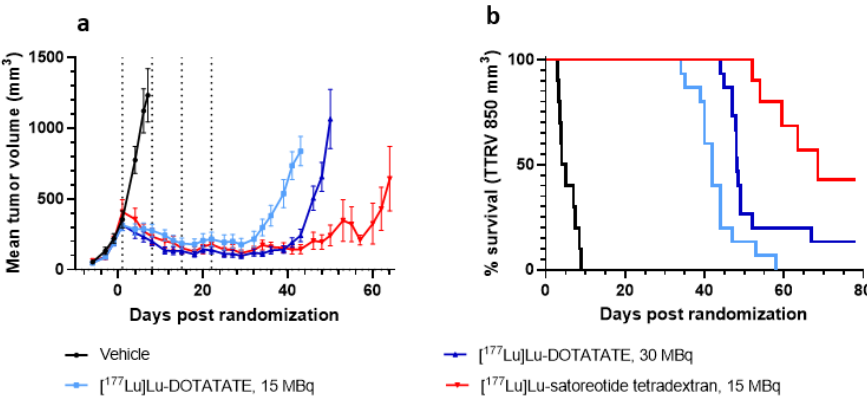
Figure 2. Anti-tumour effects of [ 177 Lu]Lu-DOTA-TATE at 15 and 30 MBq and [ 177 Lu]Lu-satoreotide tetraxetan at 15 MBq. ( a ) Tumour growth over time. Data are mean ± standard error of the mean. ( b ) Kaplan-Meier curves of Time to Reach Volume of 850 mm 3 (TTRV850). Table 2. Median tumour growth delay (95% confidence interval) .